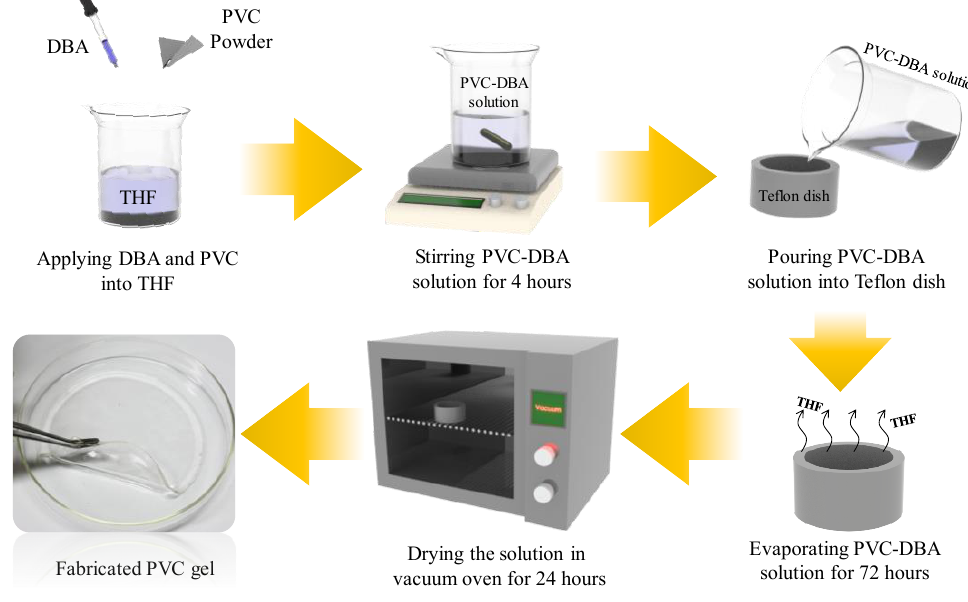
Figure 1. Process for fabrication of the electroactive PVC (poly vinyl chloride) gel.